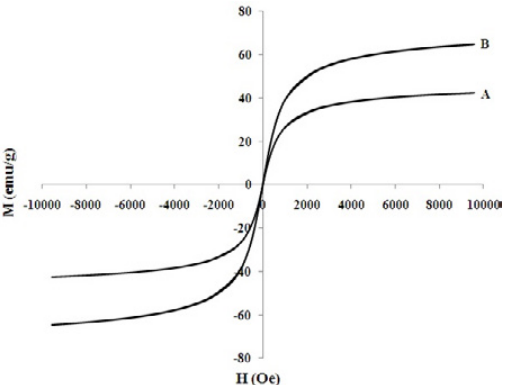
Fig. 4. VSM diagrams of samples A and B revealing their superparamagnetic